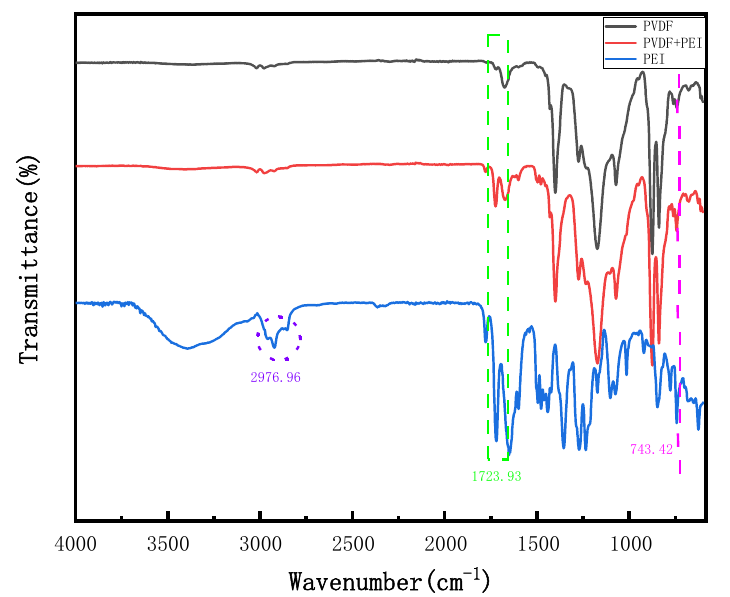
Figure 3. FTIR spectra of PVDF pure membrane, PEI pure membrane, and PVDF/PEI blend membrane.